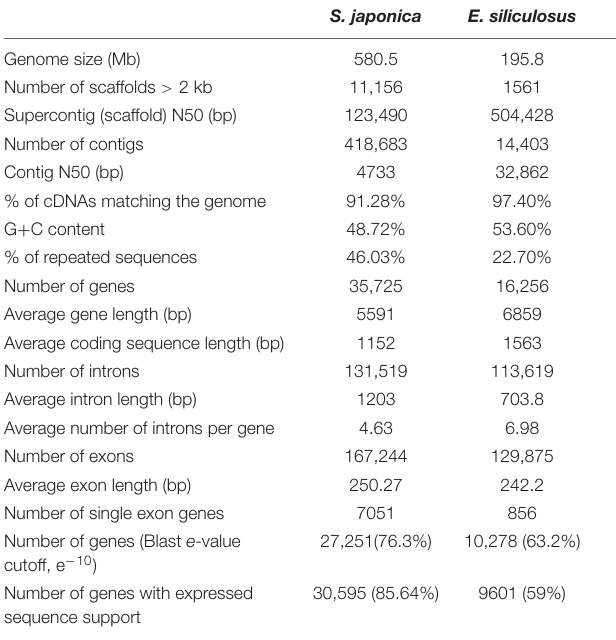
TABLE 1 | Genome statistics of S. japonica and E. siliculosus